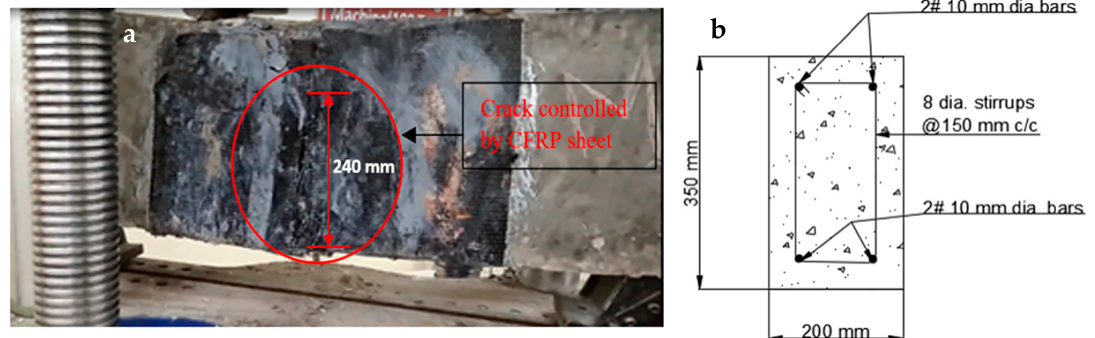
Figure 20. ( a , b ) Failure of the strengthened beam in the vertical direction.